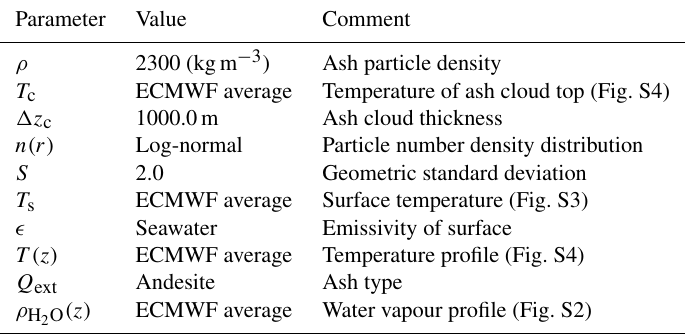
Table 3. Assumed parameters and values used for the ash cloud retrieval. “ECMWF average” means the parameter is calculated from ECMWF analysis data averaged over the region for 16–17 September 2013. See text for more details.